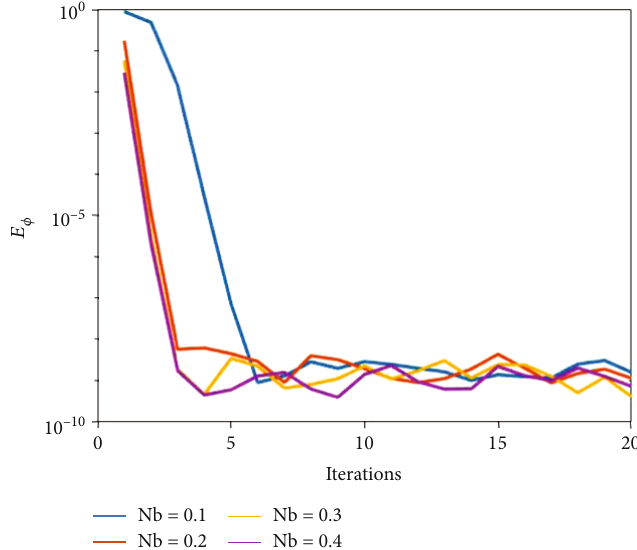
Figure 13: Concentration pro fi le for di ff erent values of Sc when λ = 0 : 1, N = 0 : 5, n = 0 : 5, f = δ = NR = 0 : 2, Sc = 0 : 6 , and Pr = 1